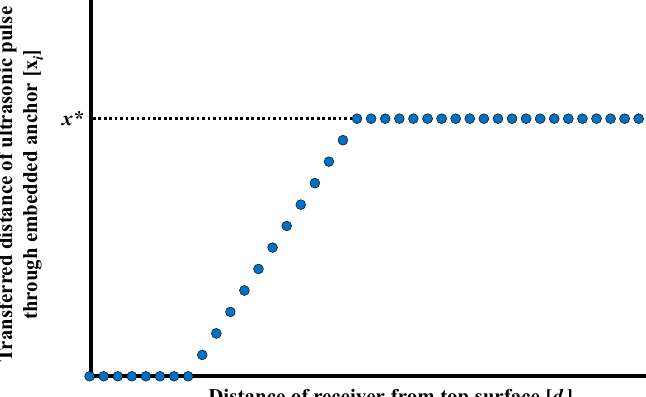
Figure 3. Theoretical value for the transferred distance of the ultrasonic pulse through the embedded anchor bolt according to the distance of the receiver from top surface.